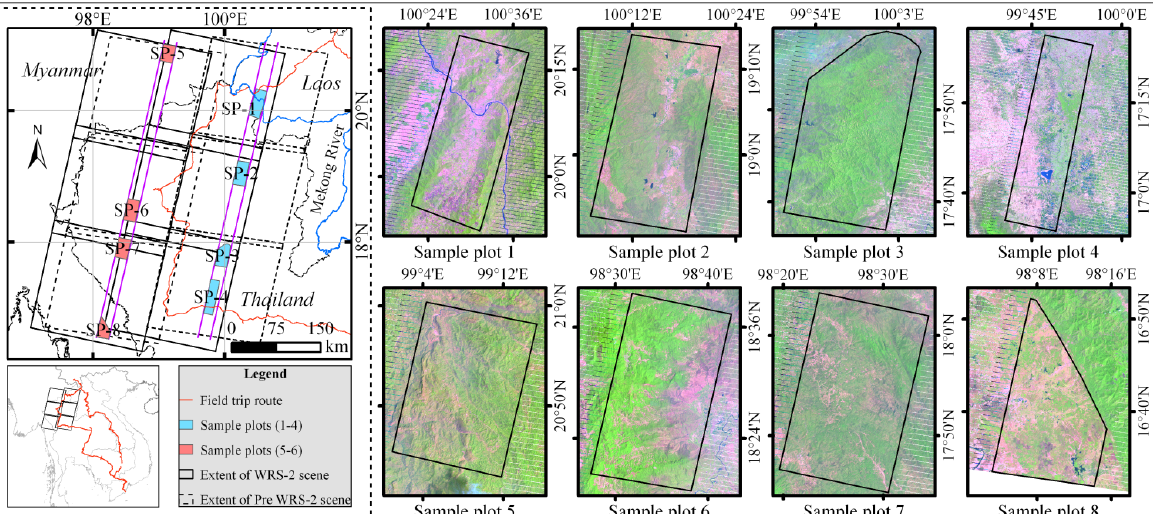
Figure 2. Locations of the eight sample plots in Mainland Southeast Asia showing the corresponding land cover types imaged in the scenes of Landsat-7 ETM+ on 25 March 2013 and 3 April 2013. The two pairs of purple solid lines refer to the central part of ETM+ Scan Line Corrector (SLC)-off scenes with the eight sample plots included. WRS, Worldwide Reference